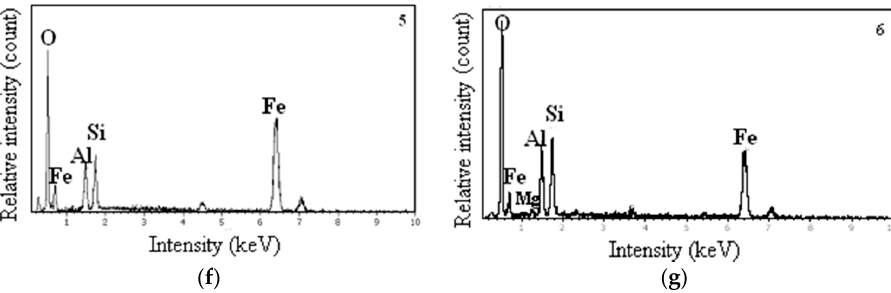
Figure 3. ( a ) The SEM image of the ferric bauxite adopted; ( b ) energy dispersive spectrometer image of